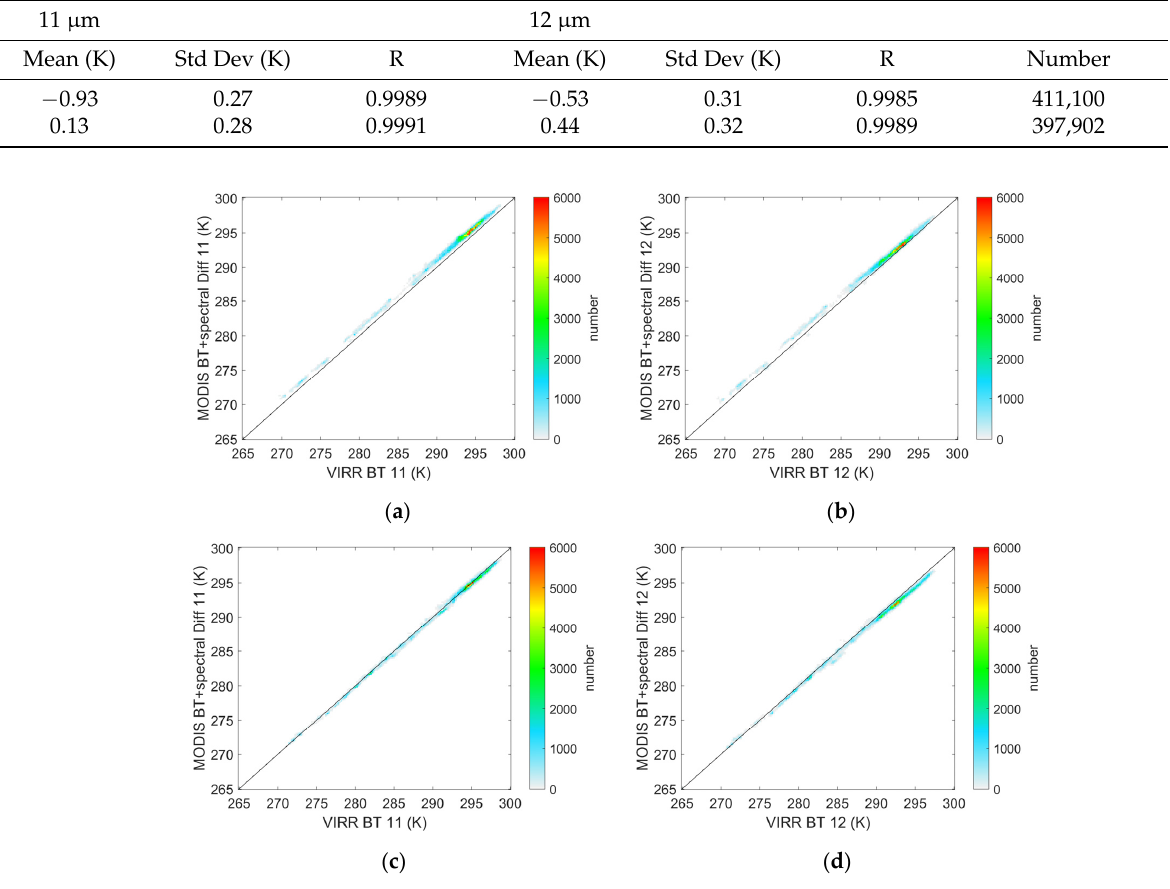
The fitting coefficients are used to correct VIRR_BT to obtain the corrected BT named VIRR_COR. The VIRR L1B BTs before and after the correction and the difference between the two are shown in Figure 5 where the gray areas are the pixels exceeding the study area, land, and obviously cloud (pixels with the BT of 11 μ m channel less than 260 K). Figure 5a–f show the images at 1:50 UTC on 28 March 2016 in the daytime, and Figure 5g–l show the images at 12:40 UTC on 11 May 2016 in the nighttime. Figure 5a–c,g–i show the 11 μ m channel images, and others show the 12 μ m channel images. After calibration, in the daytime, the BT of 11 μ m and 12 μ m channels is higher than that before calibration. The BT of the 12 μ m channel is higher in the lower BT region. In the nighttime, the BT of 11 μ m channel is close to that before calibration. The corrected BT of the 12 μ m channel is lower in the area with higher BT than before correction, indicating that the accuracy of VIRR_COR after correction is higher than before.